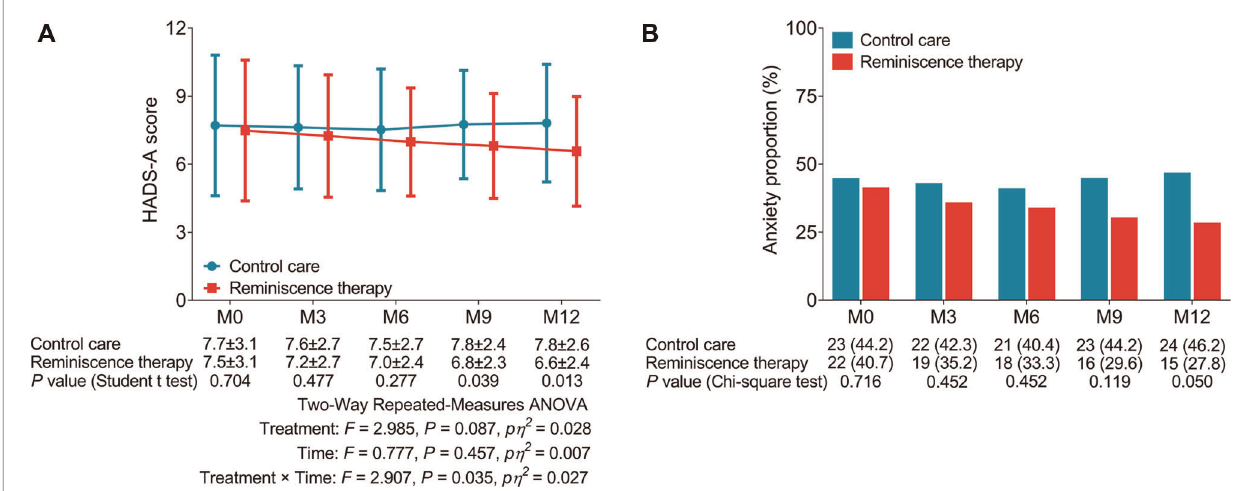
FIGURE 2 | Comparison of anxiety between the reminiscence therapy group and the control care group. Comparison of the HADS-A score ( A ) and anxiety proportion ( B ) between groups at each visit